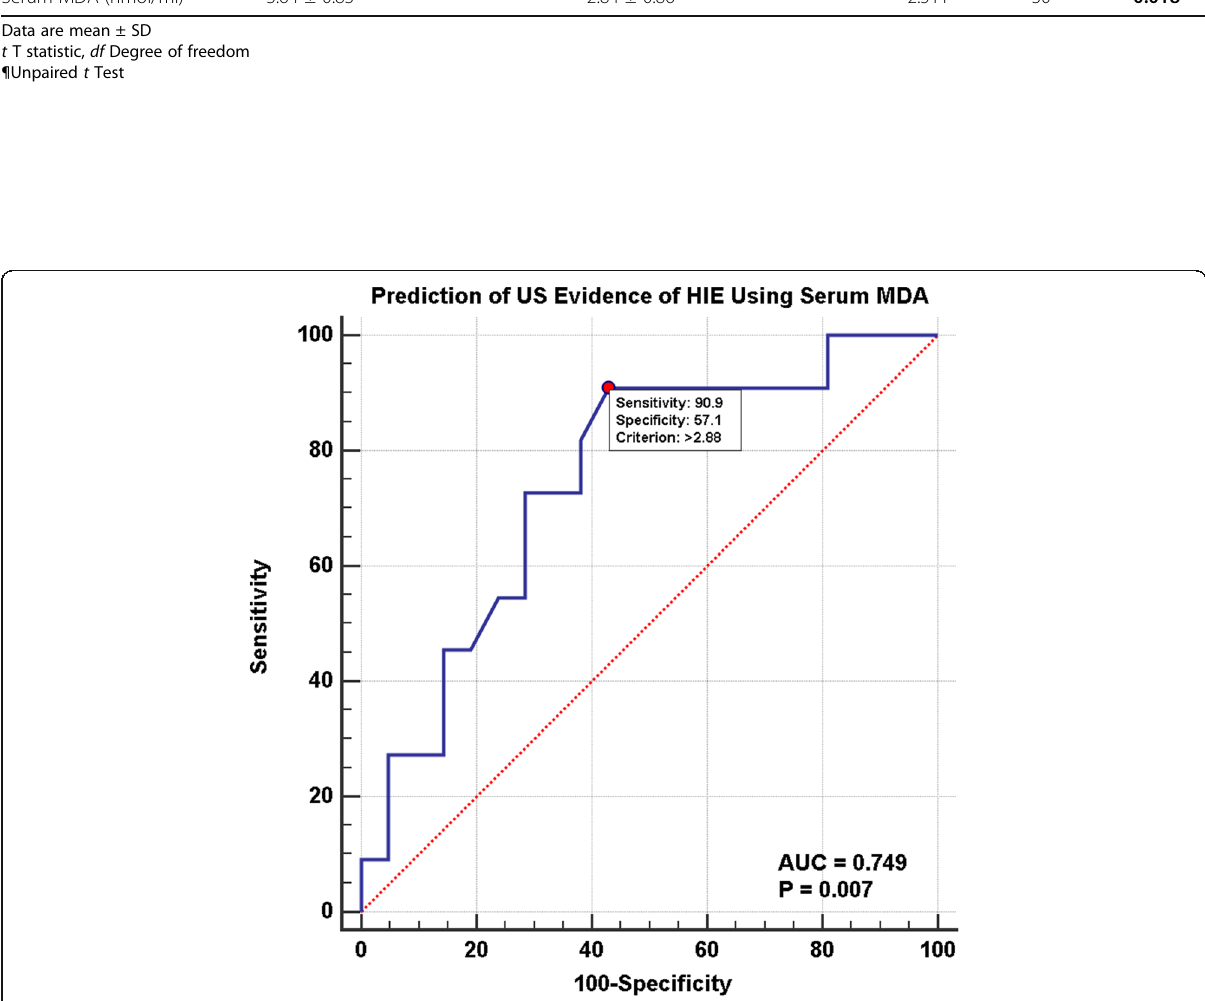
Fig. 10 ROC curve for prediction of cranial US evidence of HIE using serum MDA. There is a highly significant difference between positive and negative US findings using MDA levels ( P = 0.007). Area under curve was 0.749. Cut-off MDA in hypoxic neonates with positive US findings was > 2.88 nmol/ml. Sensitivity of MDA in positive US findings was 90.9% and specificity was